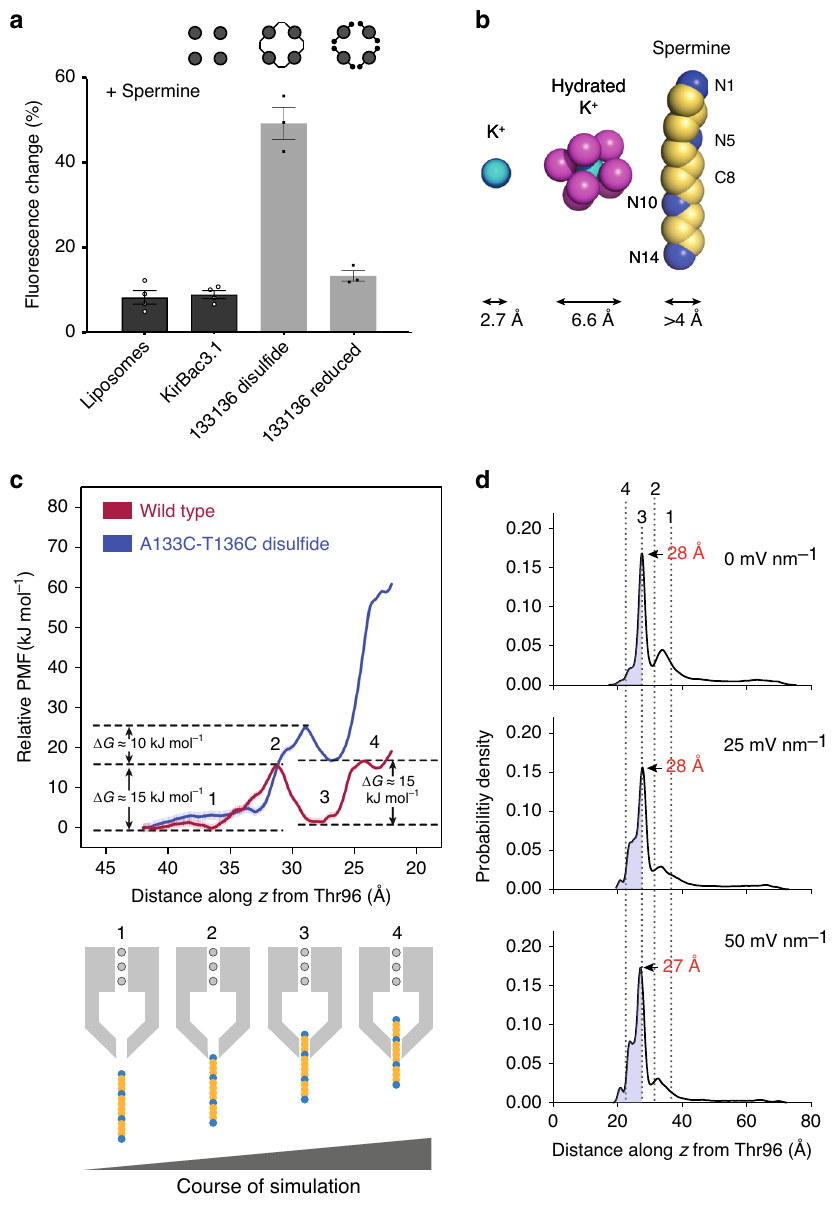
Fig. 5 Spermine enters wild type but not disul fi de-linked pores. a Summary of potassium fl ux experiments investigating spermine block in wild-type and disul fi de-linked A133C-T136C channels. Data are shown as mean ± SEM ( n = 4 (channel-free, wild type)) or 3 (A133C-T136C disul fi de, A133C-T136C reduced experiments); details of replicates are in Supplementary Table 4. Each black or white circle represents the mean of an individual experiment. b Comparative dimensions of permeant cations (K + is depicted in deep cyan, oxygen in magenta, carbon in yellow and nitrogen in blue). c The PMF represents the energetic barrier to spermine block. Positions 1 to 4 refer to the positioning of a middle carbon (C8) of spermine relative to the pore — shown in the schematic below. d The voltage-dependency of spermine block is illustrated by the trend in probability density of spermine entering the pore at fi eld strengths of 0, 25 and 50 mV nm − 1 . The shaded region of each panel corresponds to 80% of structures in the MD simulations, shown relative to positions 1 – 4. The distance of C8 relative to the center of mass of Thr96 is annotated for major peaks (red). In the region 18.0 – 27.5 Å, the occupancy sequentially changes from ~25 to 40 – 50% with increasing fi eld (0 – 25 to 50 mV nm − 1 ). The fi eld-free distribution of spermine in the cavity predicts only a small probability of spermine occupancy at position